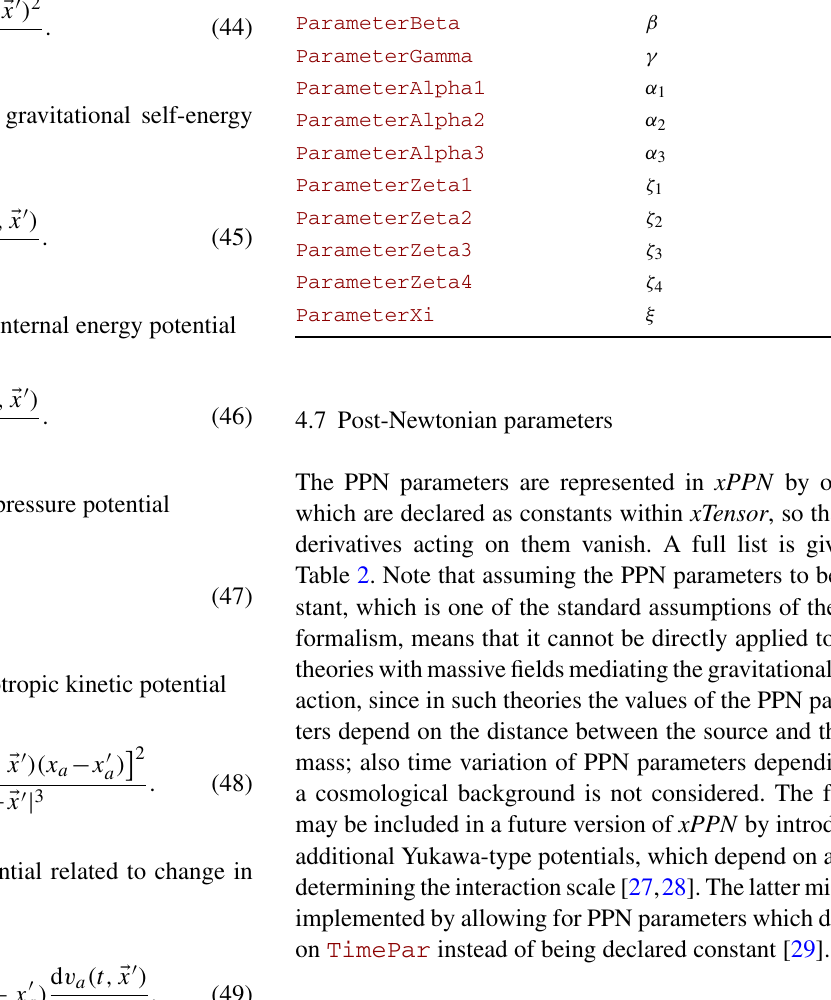
Table 2 Constants representing the PPN parameters in xPPN Symbol